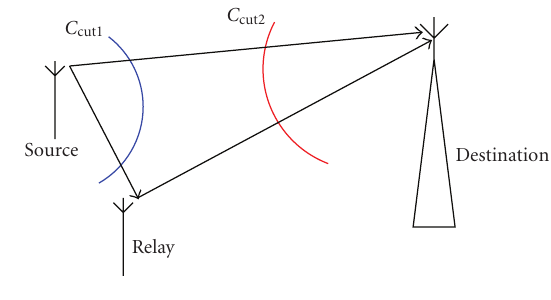
Figure 1: Cut sets of relay